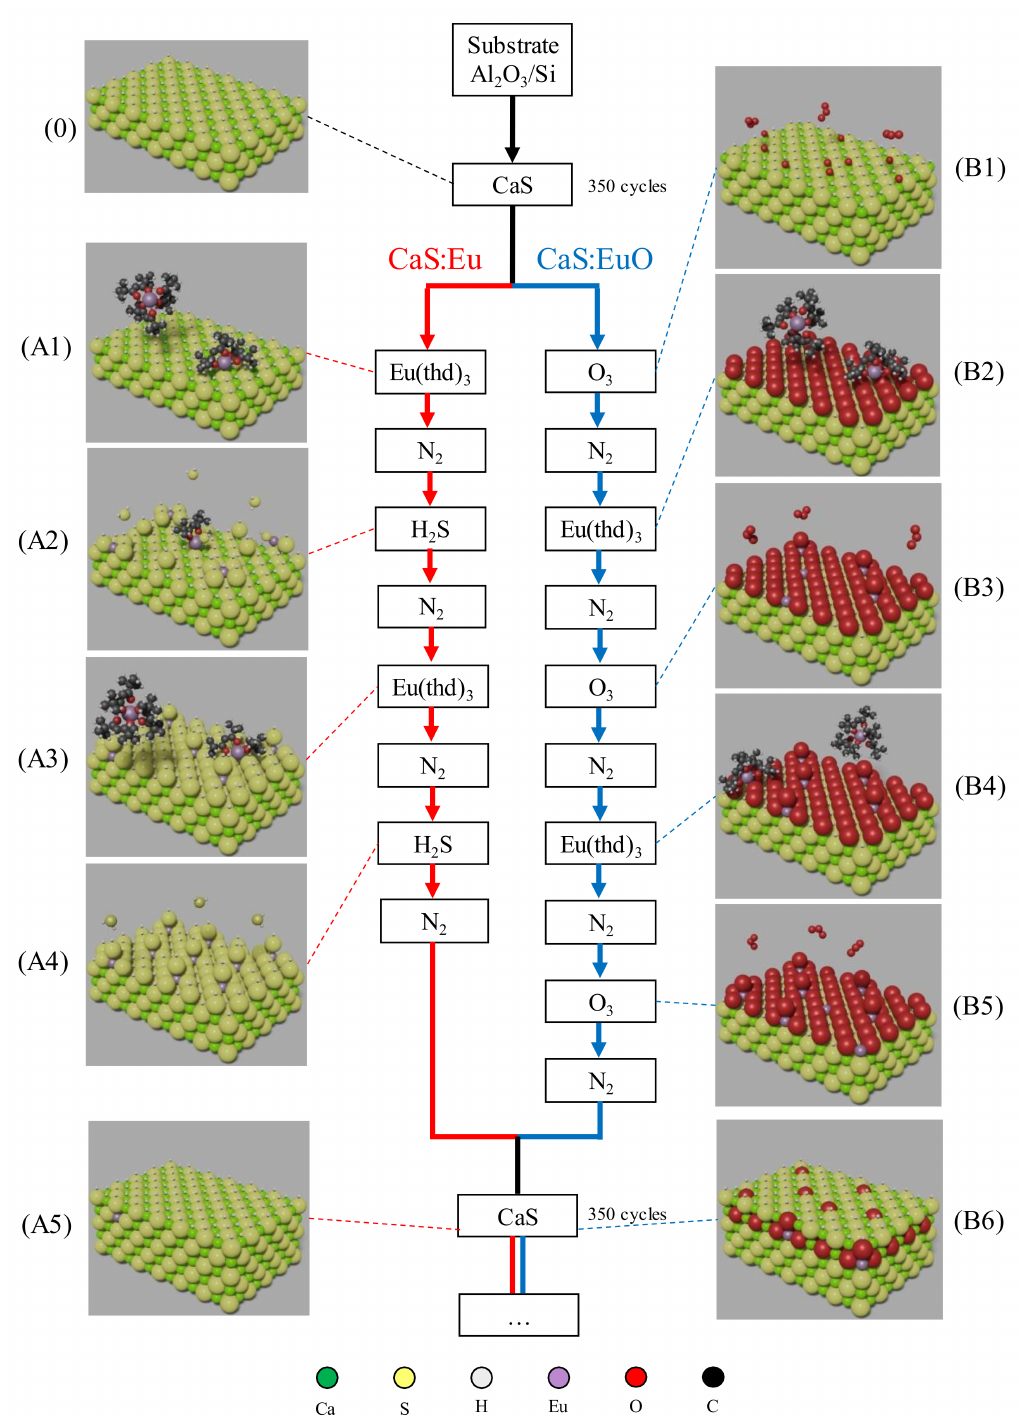
Figure 1. Schematic of ALD doping sequence used in CaS:Eu and CaS:EuO samples. ( 0 ) Top layers of CaS matrix. Red track represents the doping sequence in CaS:Eu sample including: ( A1 ) Eu(thd) 3 pulsing on CaS layer, ( A2 ) H 2 S pulsing after nitrogen purge, ( A3 ) second Eu(thd) 3 pulsing after purge, ( A4 ) H 2 S pulsing after nitrogen purge and ( A5 ) CaS monolayer after the doping sequence. Blue track represents the doping sequence in CaS:EuO sample including: ( B1 ) O 3 pulse on CaS layer, ( B2 ) Eu(thd) 3 pulsing after purge, ( B3 ) second O 3 pulsing after nitrogen purge, ( B4 ) second Eu(thd) 3 pulsing after purge, ( B5 ) third O 3 pulsing after nitrogen purge and ( B6 ) CaS monolayer after the doping sequence. Atomic elements are represented with the following colors: (Ca) green, (S) yellow, (H) gray, (Eu) lavender, (O) red and (C)